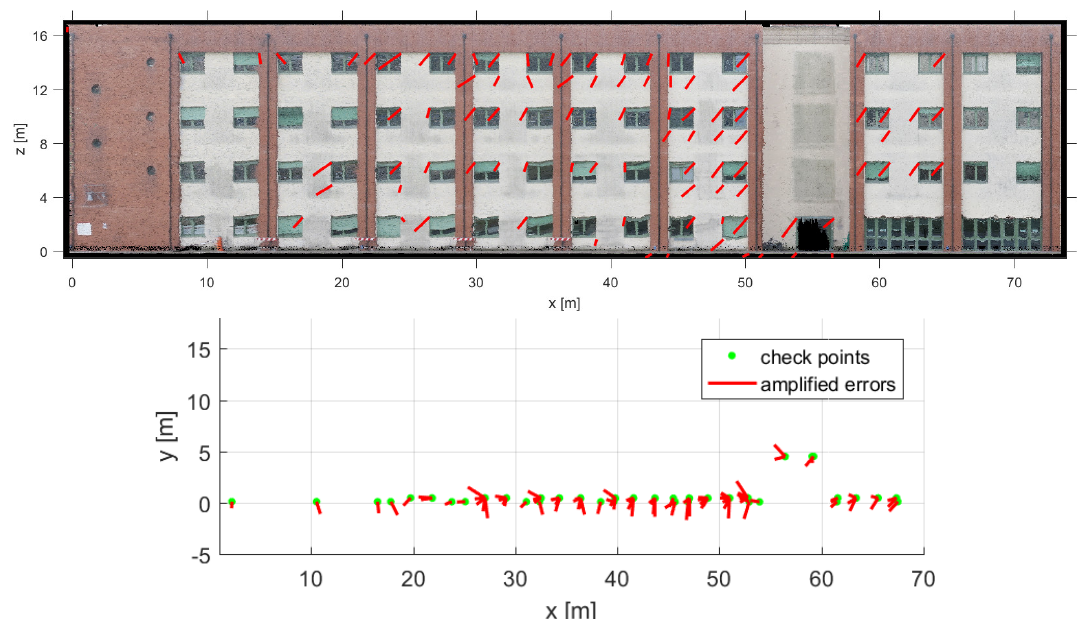
Figure 8. Errors, amplified by a factor of five with respect to the reconstruction scale, on check points for the georeferenced reconstruction. Frontal view of the building façade ( top ) and top view ( bottom